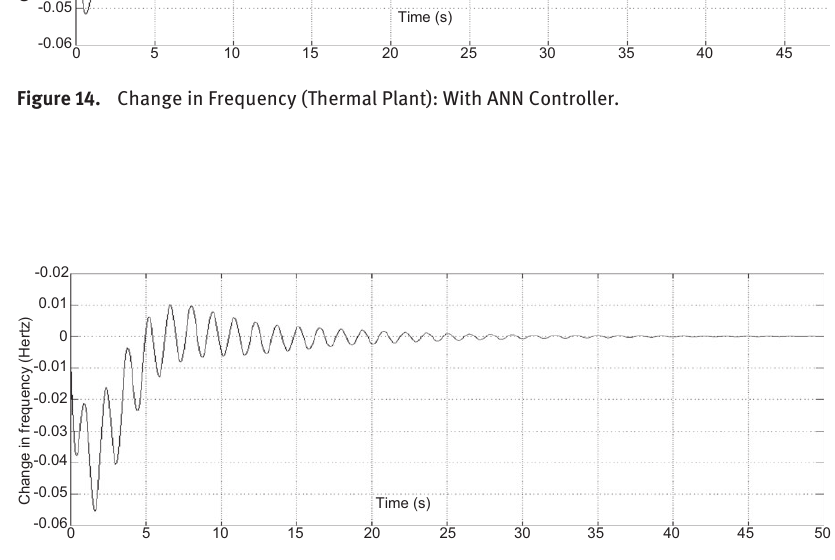
Figure 15. Change in Frequency (Hydro Plant): With ANN Controller.